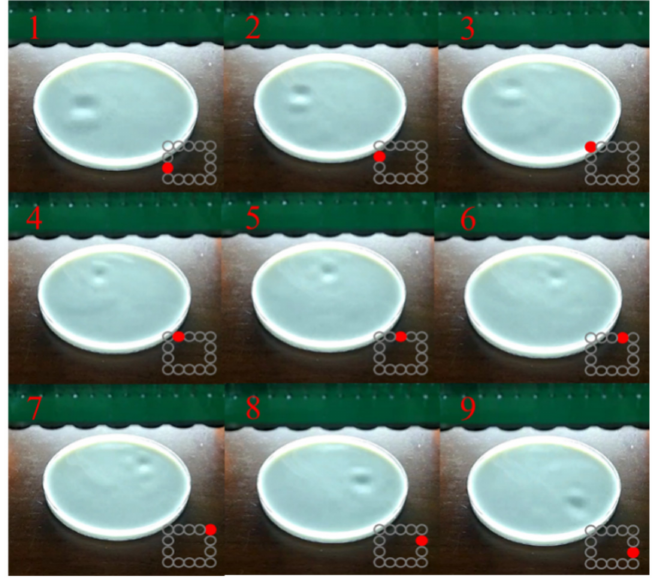
Figure 11. Dynamic movement of the ultrasound focal